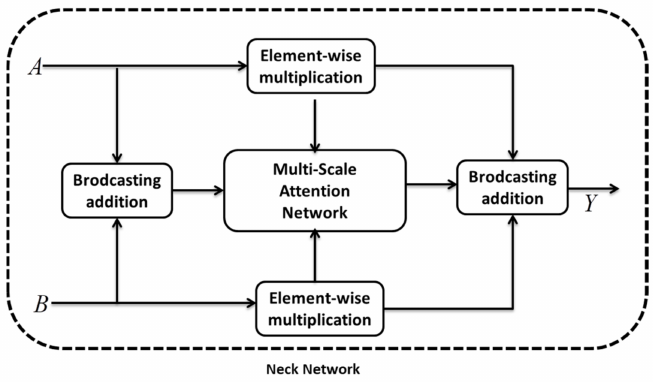
Figure 13. Architecture of the MAFFN_YOLOv5 Neck